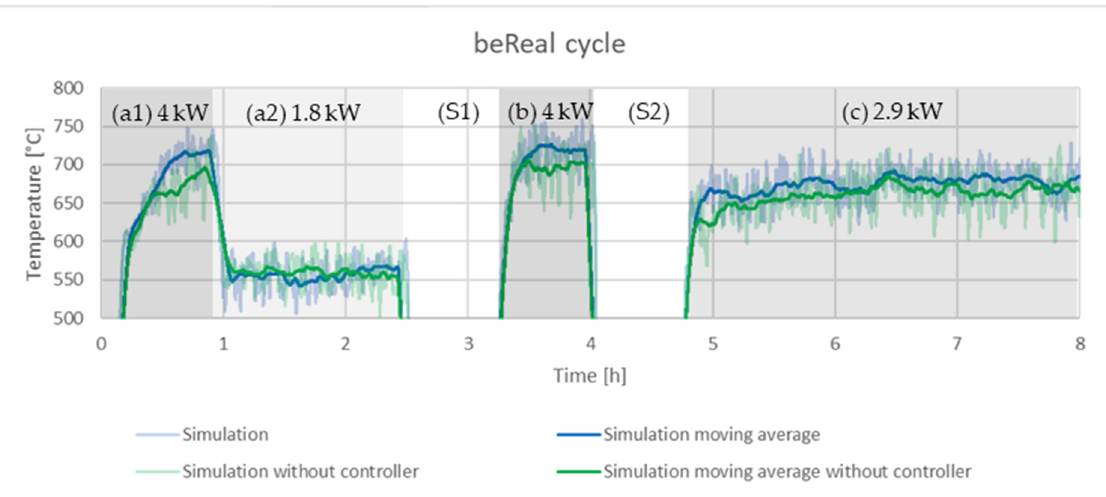
Figure 13. Load cycle simulations—comparison between an operation with fully open air flap (blue) and controlled operation (green).